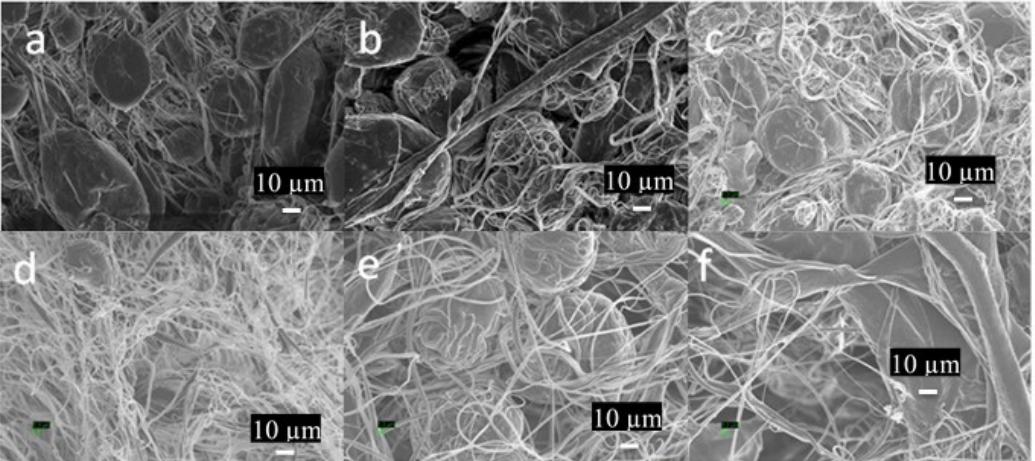
Figure 2. SEM images of PCL fibers prepared with THF as the only solvent with different PCL concentrations using different rotational speeds. ( a ) PCL 7.5 wt% at 4000 rpm; ( b ) PCL 7.5 wt% at 10,000 rpm; ( c ) PCL 10 wt% at 4000 rpm; ( d ) PCL 10 wt% at 8000 rpm; ( e ) PCL 15 wt% at 10,000 rpm; ( f ) PCL 17.5 wt% at 10,000 rpm.